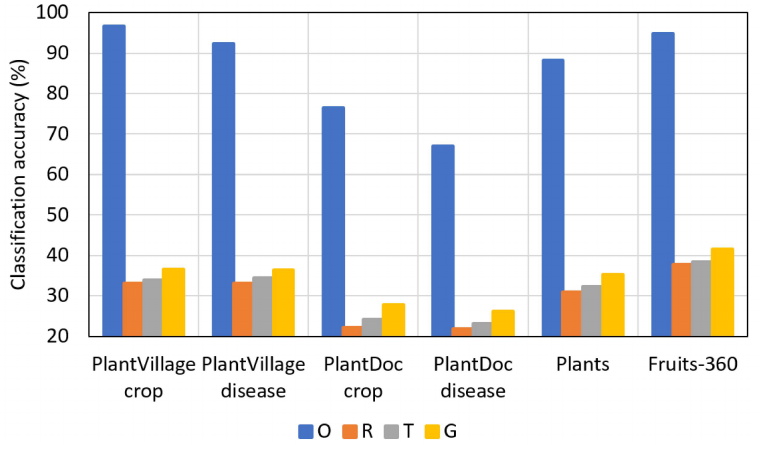
Figure 14. Comparison of F1-scores based on all the datasets (original dataset (O), reduced dataset (R), dataset augmented by conventional method (T), and dataset augmented by PI-GAN (G)). The datasets have been reduced to